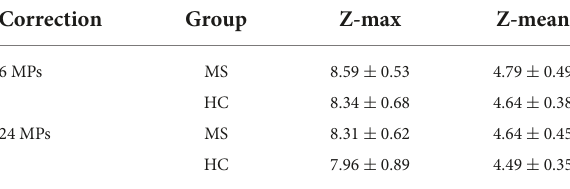
TABLE 2 Metrics to assess the quality of the models using motion correction of gradual head shifts with 6 MPs and 24 MPs.